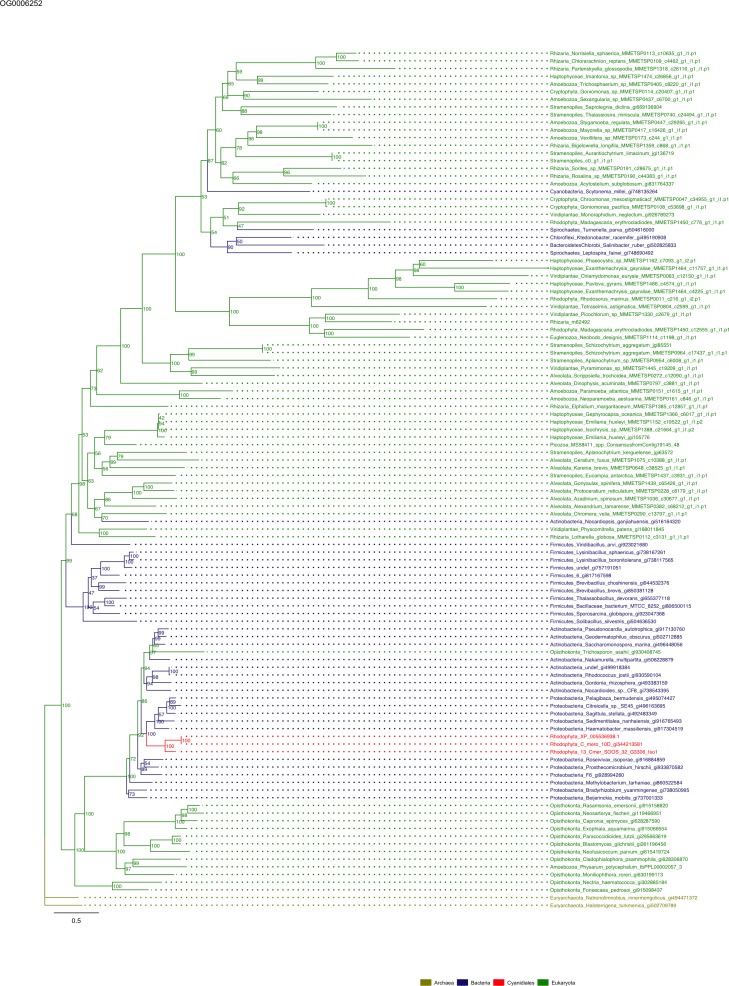
Sequence tree of orthogroup OG0006252.The tree is based on amino acid sequences. Archaea (yellow), Bacteria (blue), Cyanidiales (red), Eukaryotes including other red algae (green). Branches containing Cyanidiales sequences are highlited in red.